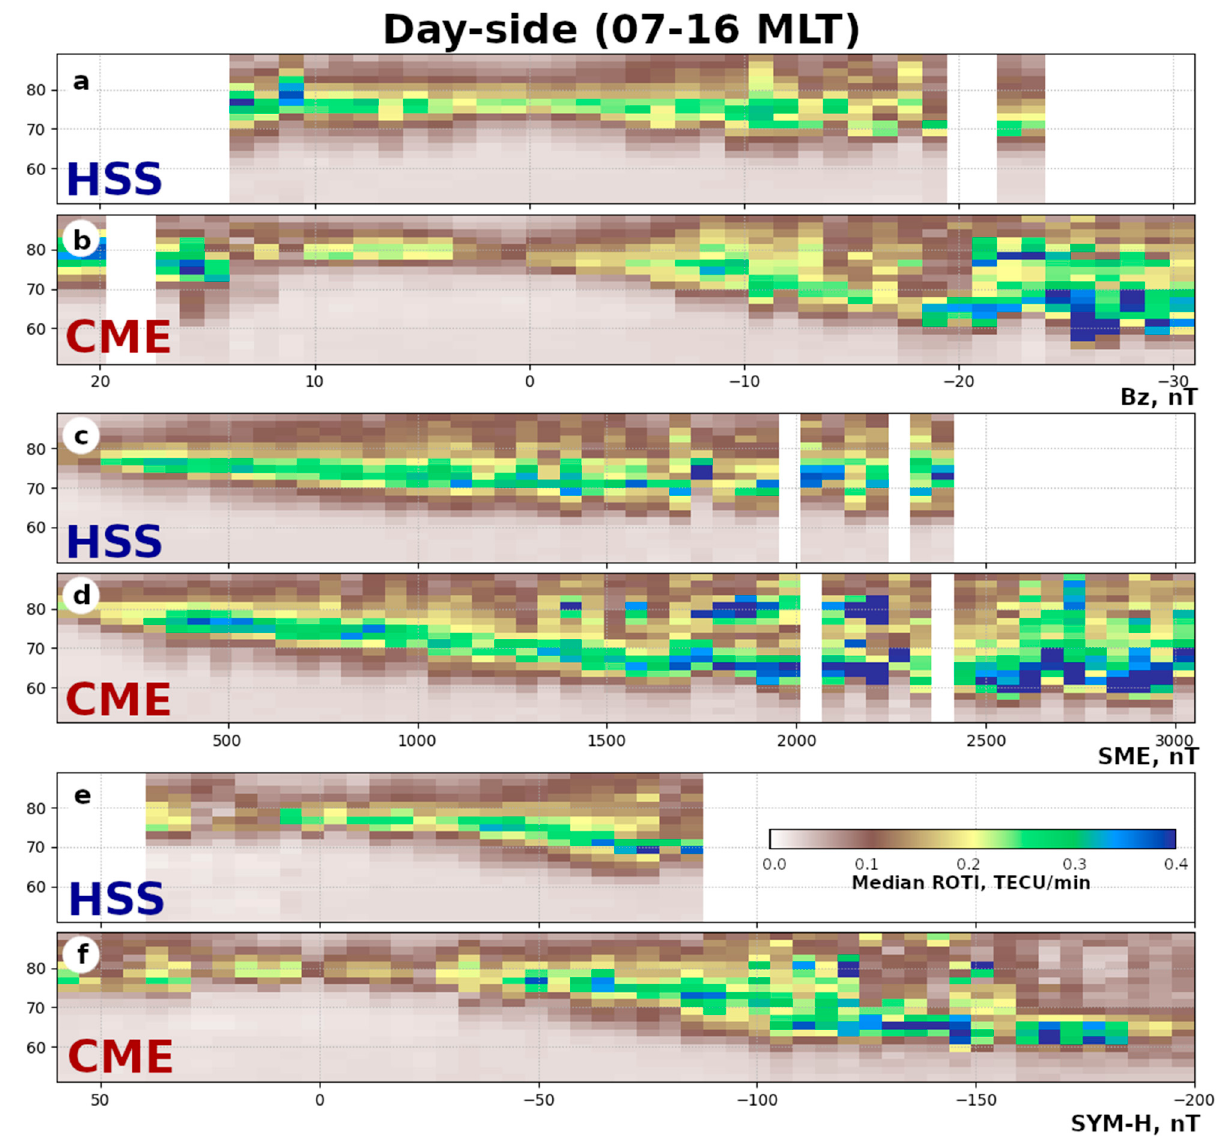
Figure 15. Median ROTI versus magnetic latitude MLAT and IMF Bz (a, b), SME (c, d), and SYM-H indices (e, f) during magnetic local day (7–16 MLT) of HSS- and CME-driven storms.